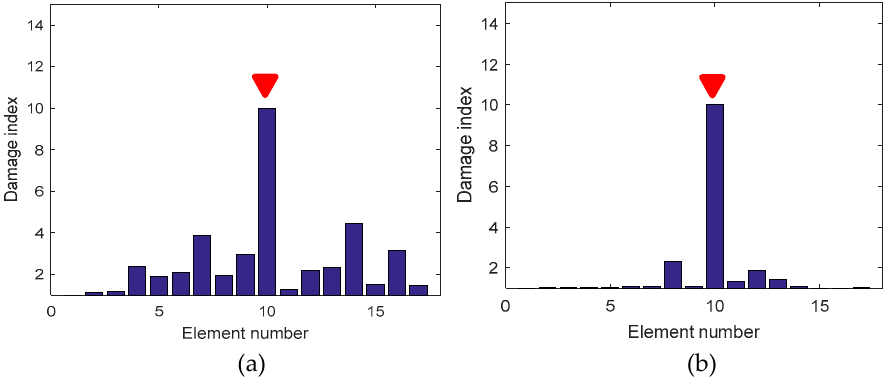
Figure 10. Corrosion detection for Level 1. ( a ) Damage index for Case 1; ( b ) Damage index for Case 2.